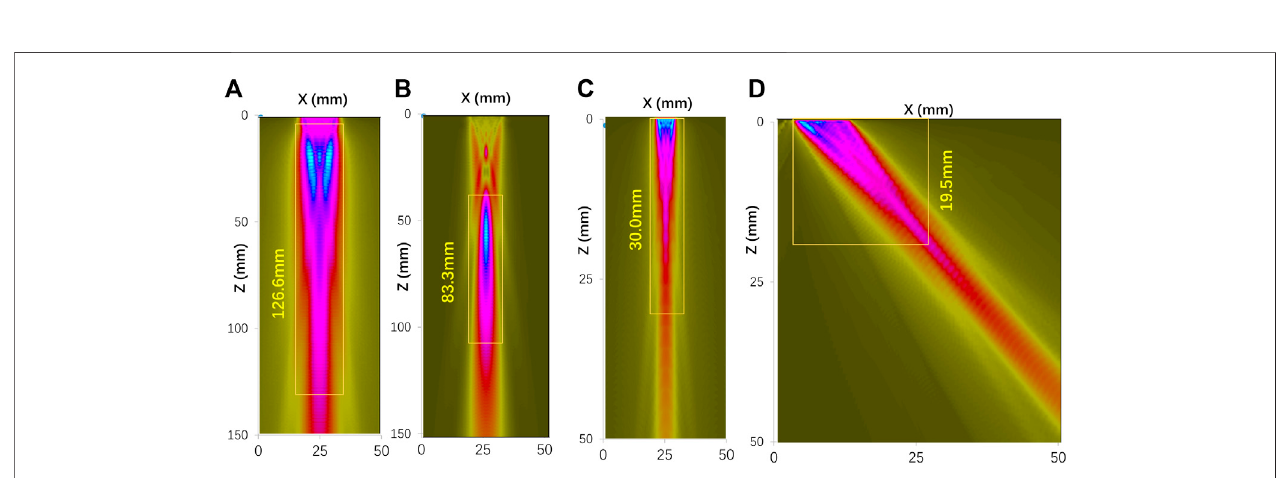
FIGURE 3 | Sound fi eld coverage simulation: (A) E4/E5 for leaf zone; (B) E4/E5 for thread zone; (C) E1 for thread zone; (D) E2/E3 for transition zone.